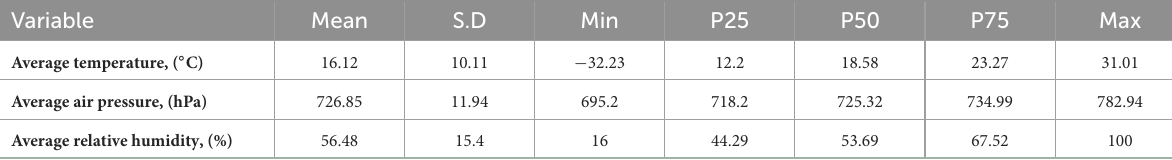
TABLE 3 Summary statistics for the VM cases and weather parameters in Kazakhstan.